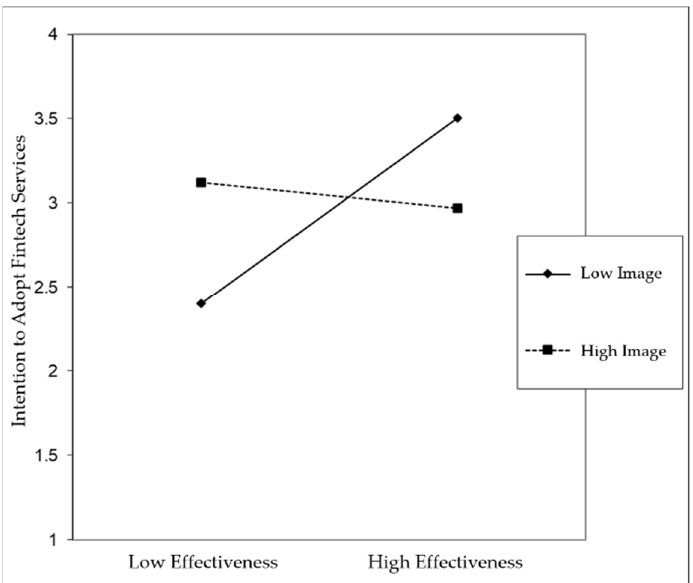
Figure 3. Interaction Perception of Image of Fintech Services × Perception of Effectiveness of Fintech Services (Source: Microsoft Excel 365).